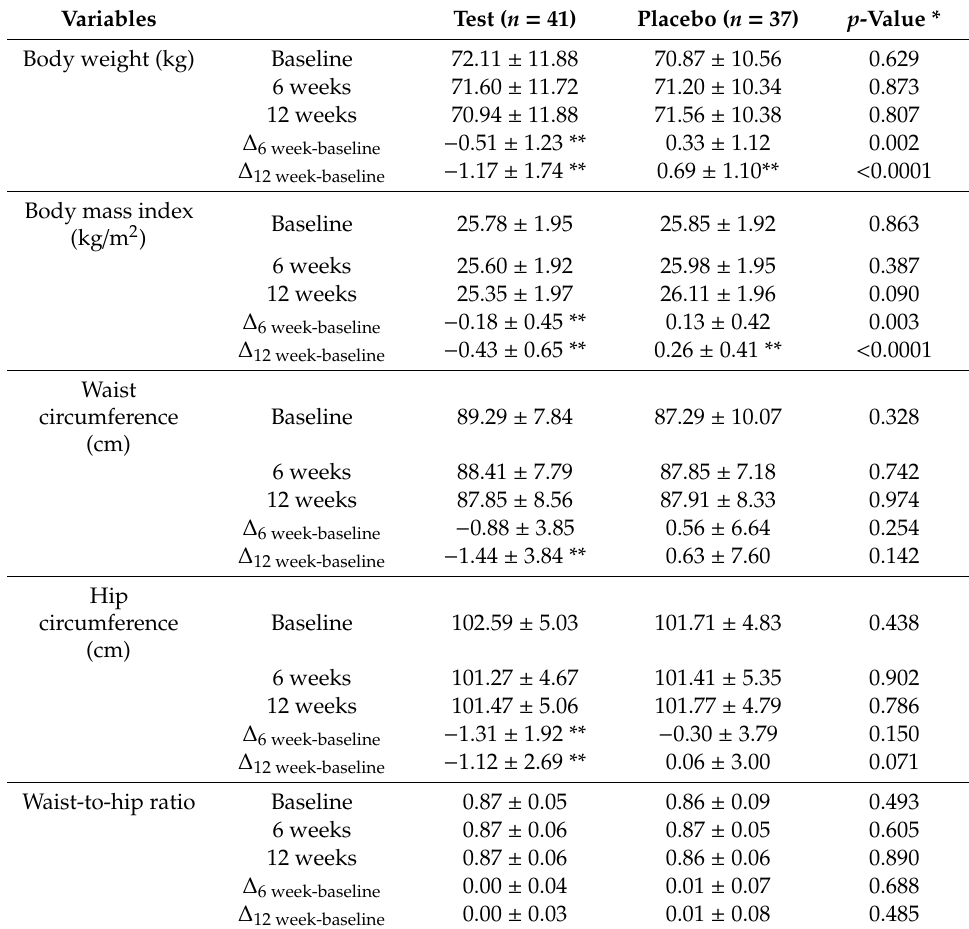
Table 3. E ff ect of Gelidium elegans on anthropometric